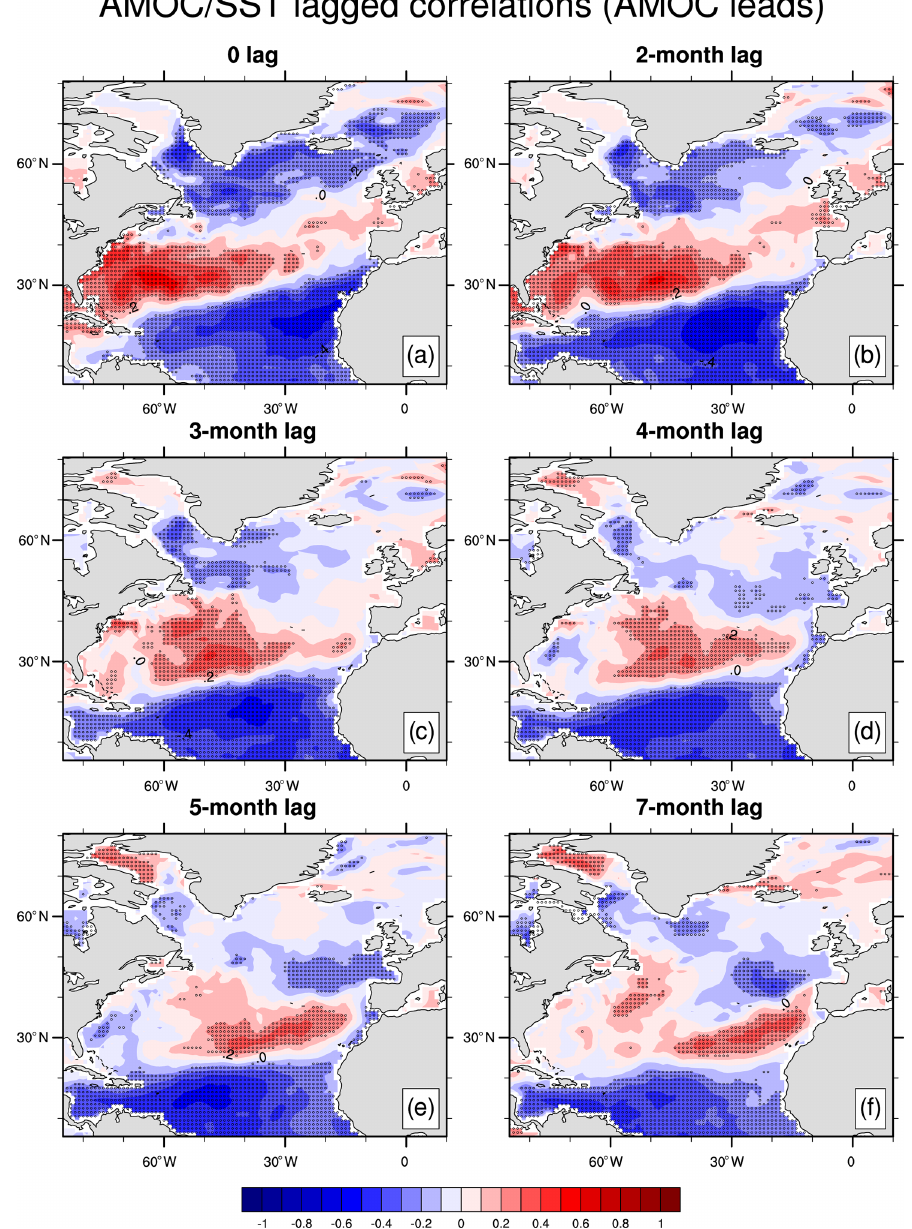
Figure 2. Lagged correlations between the AMOC at 26 ◦ N and North Atlantic SSTAs during the RAPID period (2004–2014), with the AMOC leading ( a–f , as labelled) in the assimilation experiment. The stippling represents significant correlations at the 95% confidence level, calculated from 1000 bootstrap